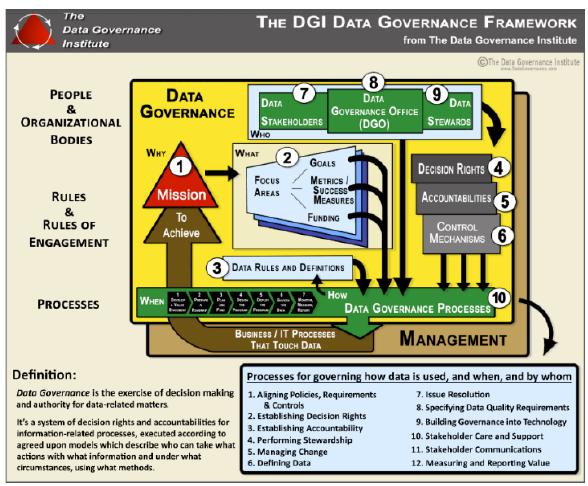
Figure 3. DGI Data Governance Framework